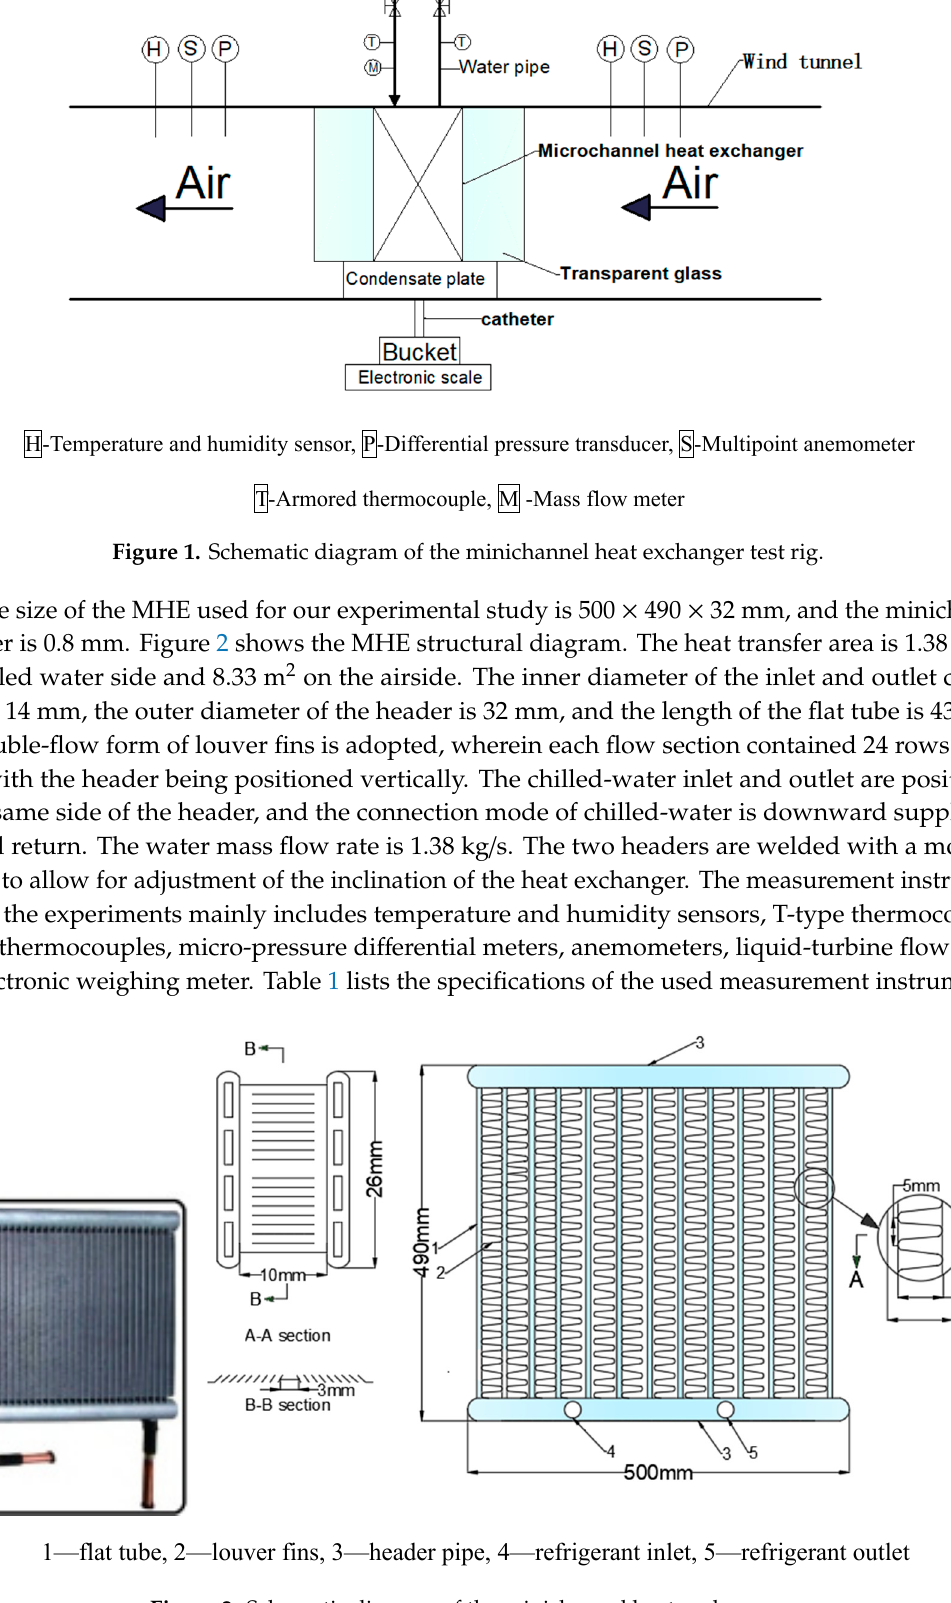
Figure 2. Schematic diagram of the minichannel heat exchanger.